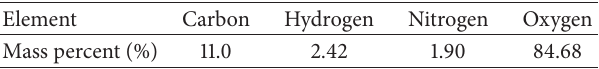
Table 5: Elemental analysis results on byproduct during decompos- ing the